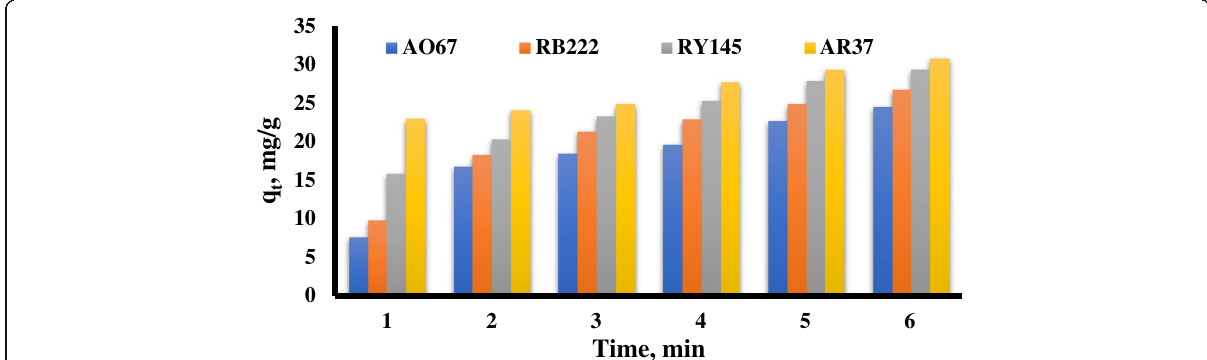
Fig. 20 Effect of contact time on removal % of RB 222, RY 145, AO67, and AR37 by RPSF at optimum